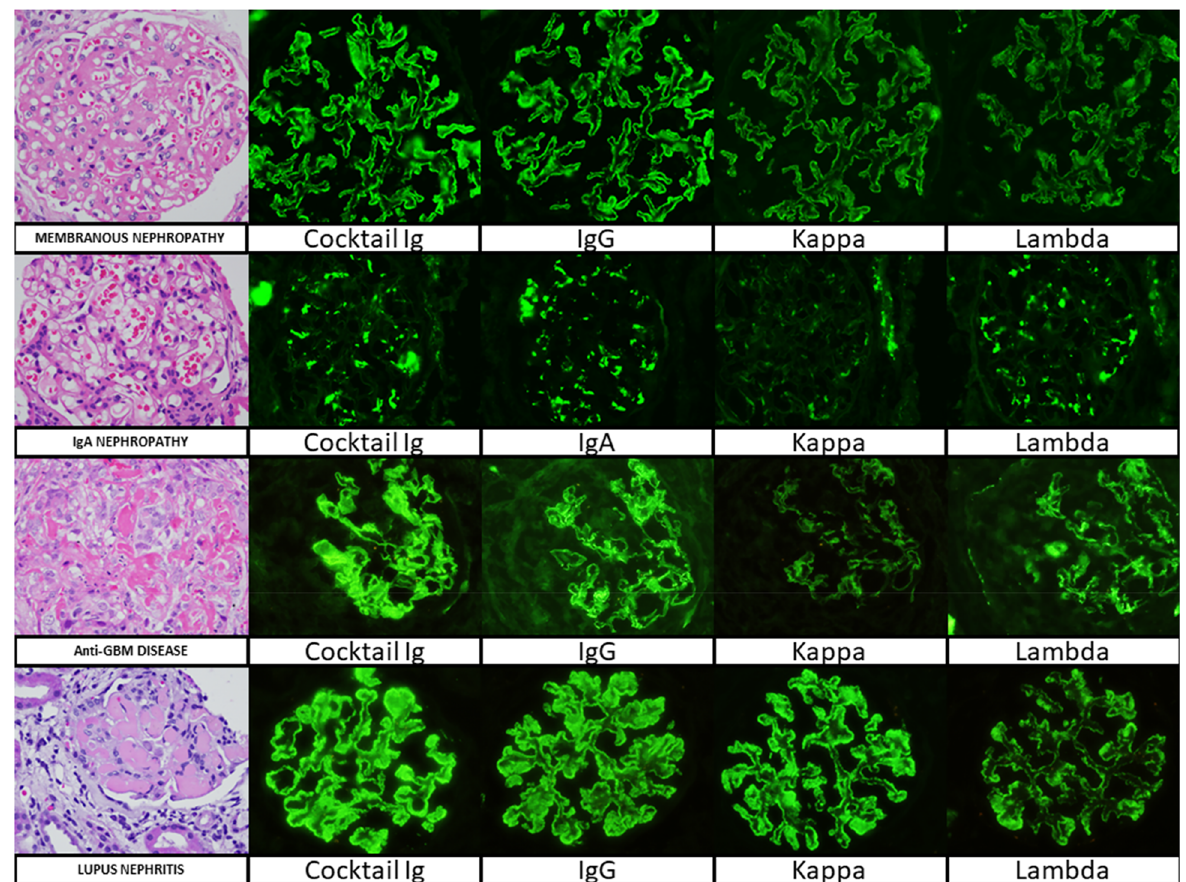
Fig. 1 A comprehensive image panel comprising of light microscopy images (hematoxylin and eosin stain, 400x) and corresponding IF images (400x) with polyvalent cocktail immunoglobulin (Ig), IgG, IgA, Kappa, Lambda positive (